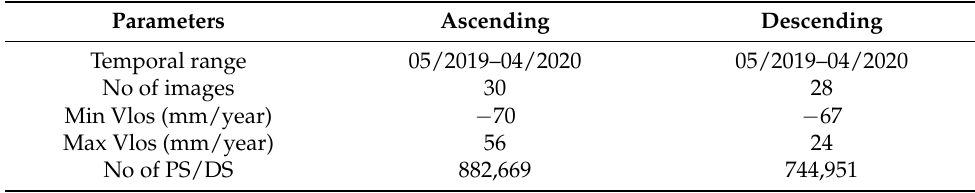
Table 5. Details of PS InSAR